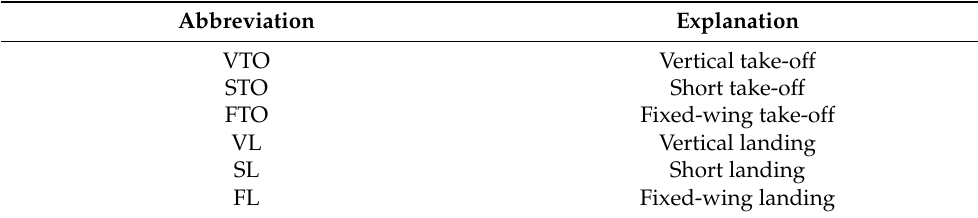
Table 1. Common take-off and landing strategies of V/STOL aircraft [7].